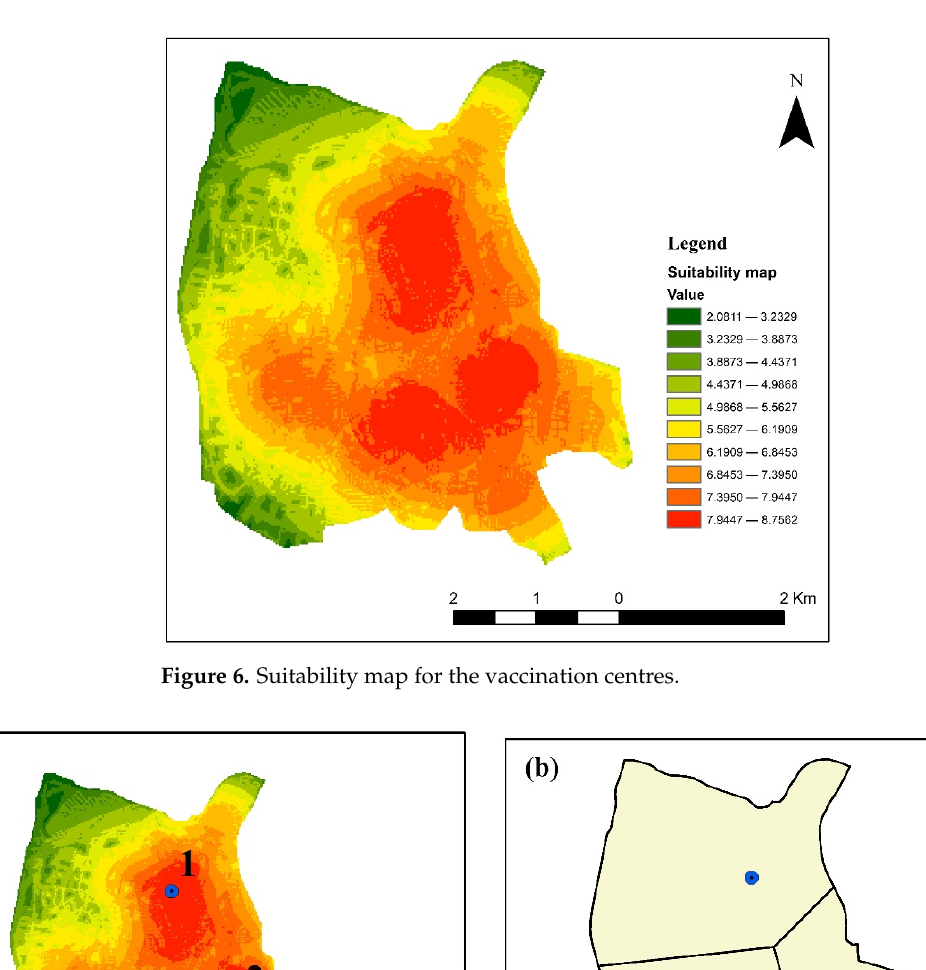
Figure 6. Suitability map for the vaccination centres.